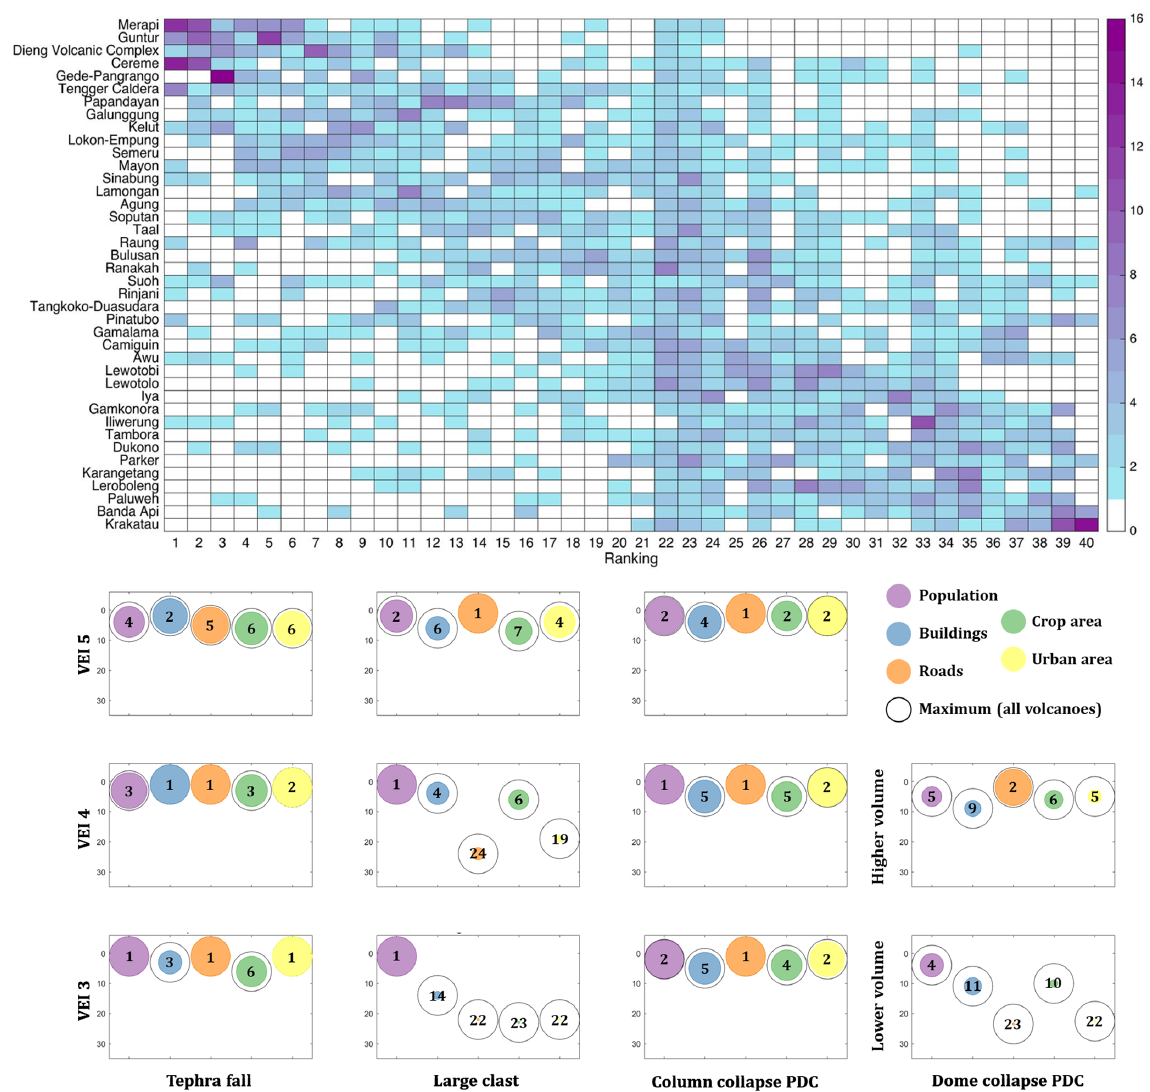
Figure 11. Upper panel: heat map to show the number of times (cell colour) that a certain rank ( x axis) is assigned for each volcano ( y axis) for the 55 ranking permutations across hazard, VEI/volume, and exposure; lower panels: individual ranks and exposure estimates for our highest overall ranked volcano, Merapi. The y axis and text numbers show the rank for each combination of hazard (columns), VEI or volume (rows), and exposure (colour), with the size of the circle reflecting the exposure values normalised to the largest value for that combination from any of our 40 study volcanoes; the black circle represents this largest value. For example, for a VEI 3 tephra fall from Merapi, while buildings rank higher (3) than crop area (6), the exposure value for crop area is closer to the maximum calculated across all of our volcanoes than it is for